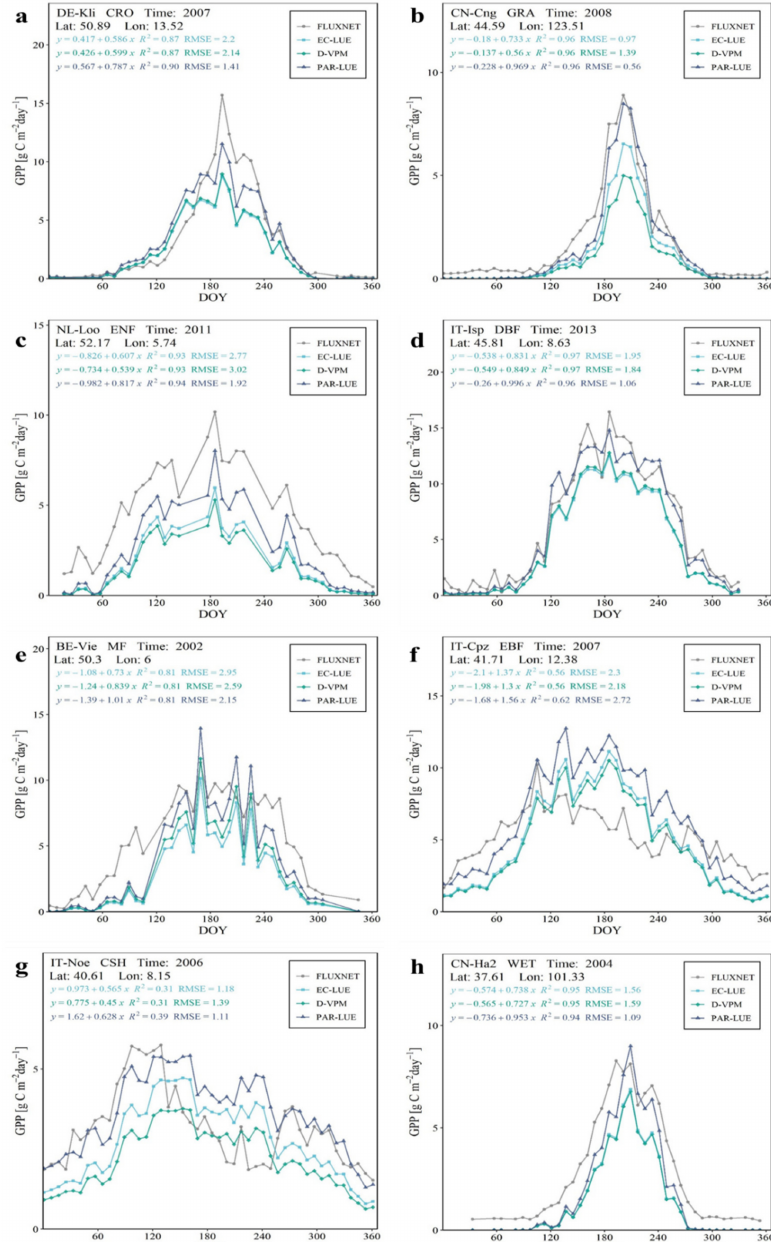
Figure 7. Comparison of GPP seasonal variation at typical sites. Eight site-year samples (( a – h ), Lat: latitude; Lon: longitude; see Figure 1 for vegetation types) with similar or concurrently higher R 2 values were selected to exhibit the better performance of the PAR-LUE model in further reducing the